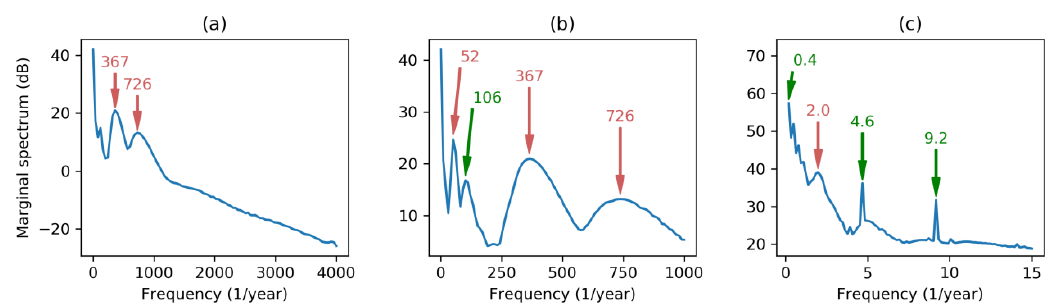
Figure 5. Electricity demand Marginal Wavelet Spectrum: ( a ) Low frequencies; ( b ) medium frequencies; ( c ) high frequencies.